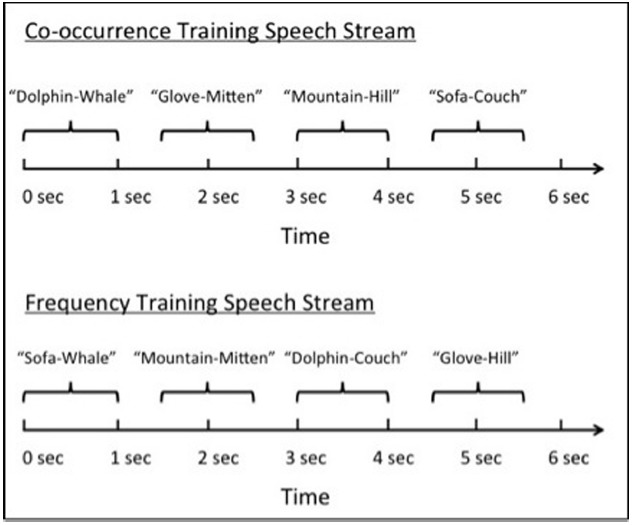
Schematic depiction of the Co-occurrence Training speech stream (top) and Frequency Training speech stream (bottom).